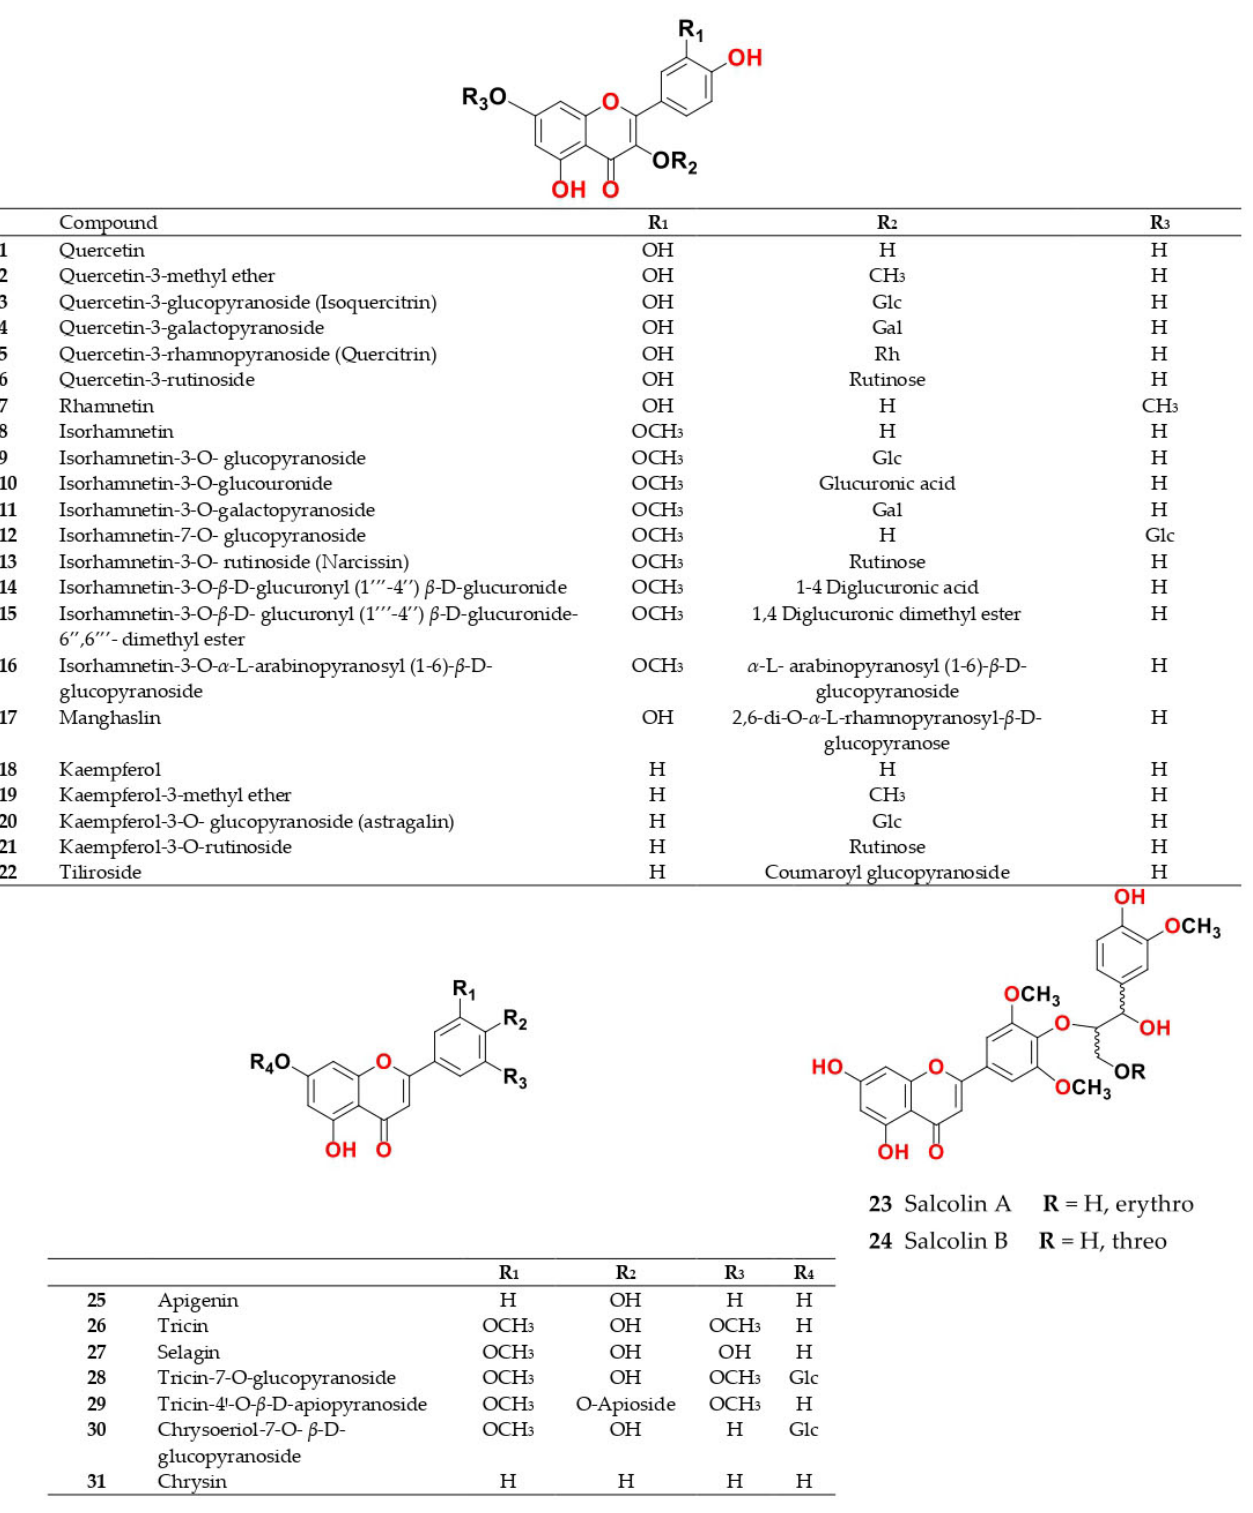
Figure 4. Chemical structure of flavonoids ( 1 – 31 ) isolated from genus Salsola.